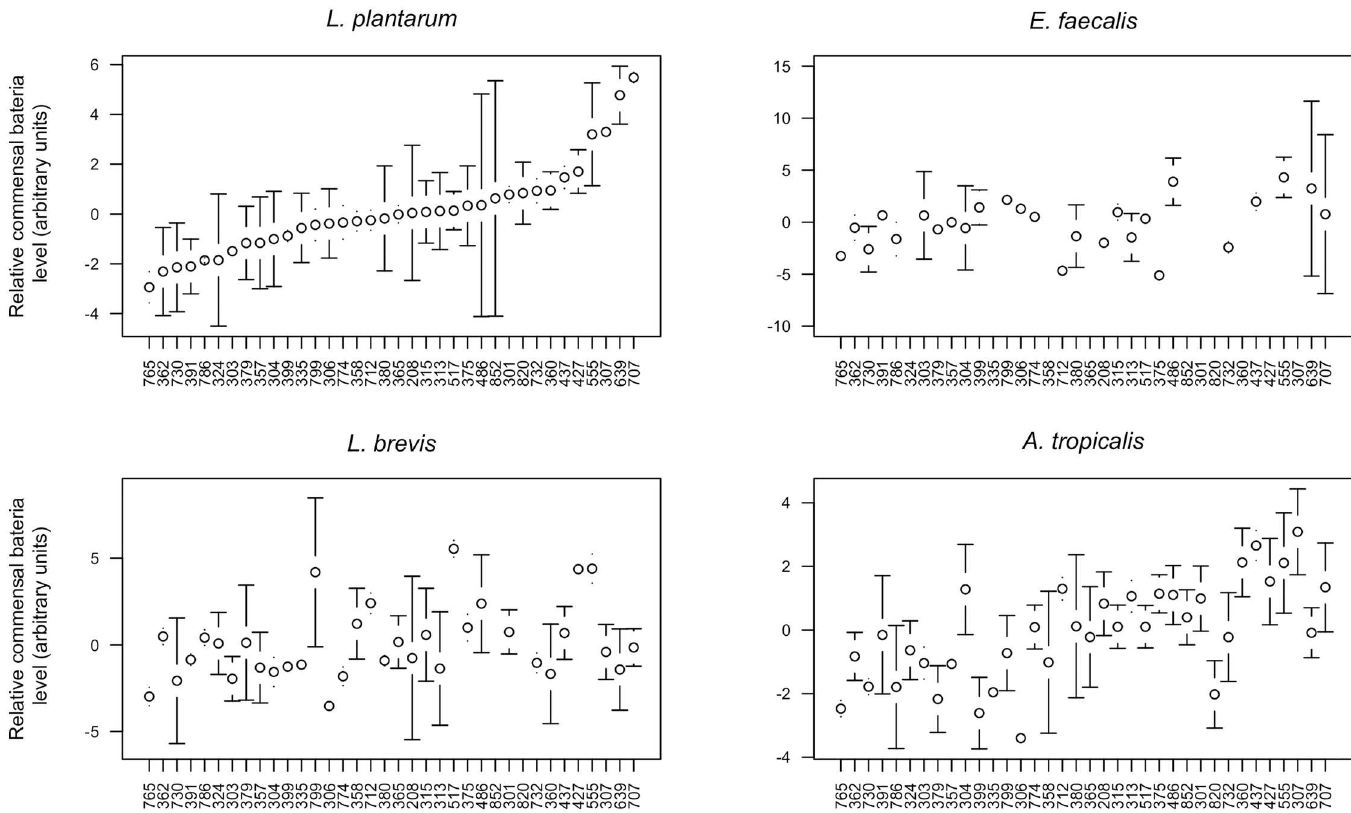
Fig 1. Relative size of commensal bacteria populations in 36 inbred fly lines. Relativecommensalbacterial level was determined using quantitative PCR and was calculatedrelative to levels of a singlecopy Drosophila gene (Drosophila gene Ct—Bacterial gene Ct). The y-axis shows the residualsof these measurements from a model accountingfor block effect (mean ± 1 S.D.). Units are on a log2 scale. Higher values correspond to a higherratio of bacterial DNA to fly DNA. In all plots, the lines are orderedaccordingthe rank order of the L . plantarum residuals.